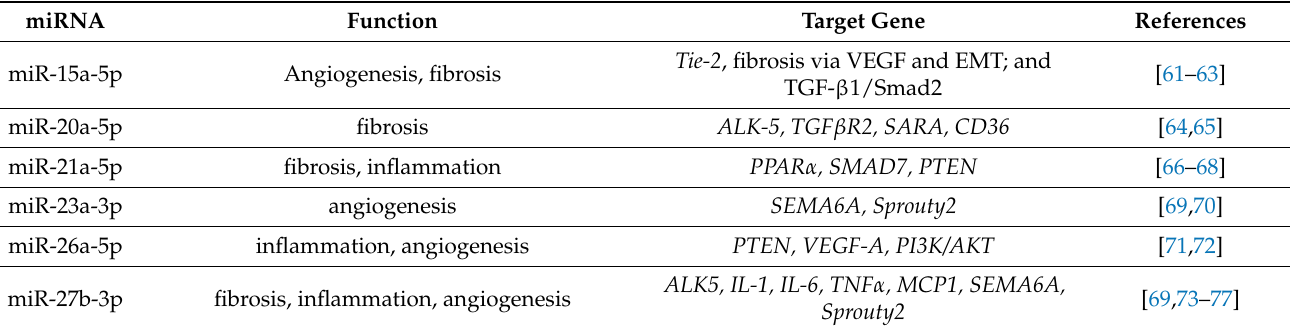
Table 1. Selected miRNAs that are potentially involved in MetS pathogenesis, with some of their confirmed targets. miRNA Function Target